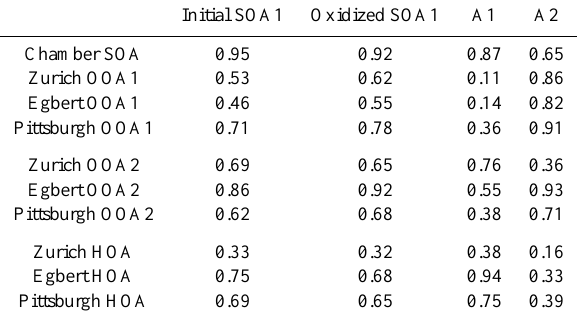
Fig. 6. Relative changes in time series mass contributions of PMF factors A1 and A2 (deconvolved from SOA1 oxidation data) with OH exposure with bottom x-axis in experimental exposure, top x- axis in atmospheric exposure time assuming [OH]=1 × 10 6 cm − 3 . Lines are to guide the eye. Error bars represent one standard devia- tion of average